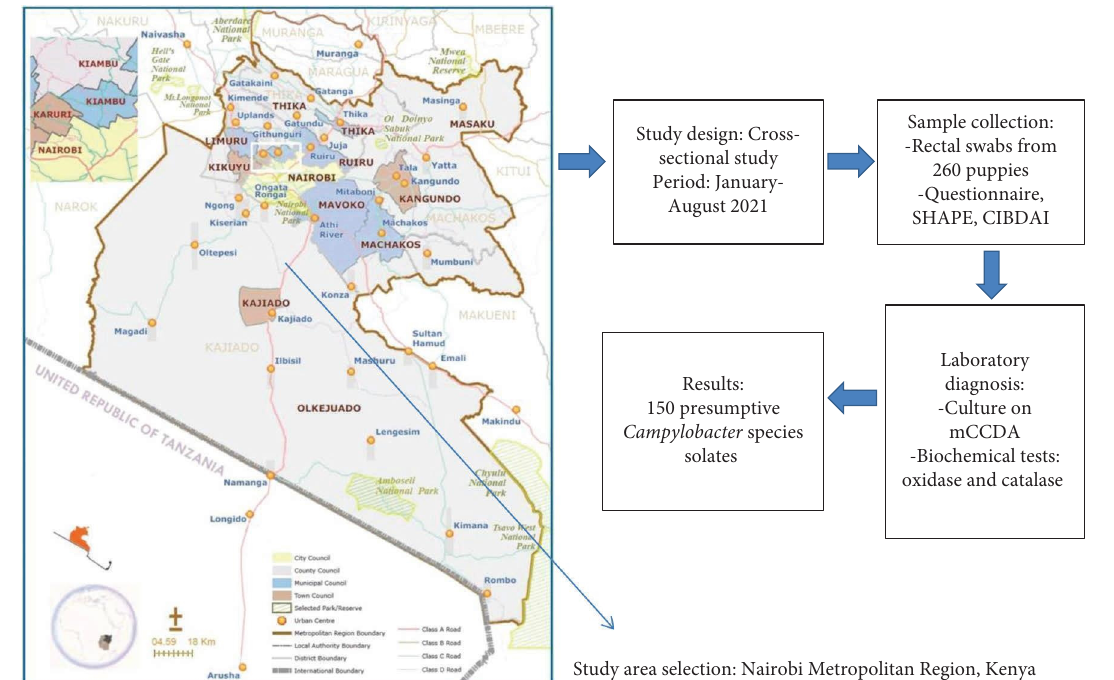
Figure 1: Schematic diagram of study design indicating the study area, puppy sampling, and laboratory diagnosis.